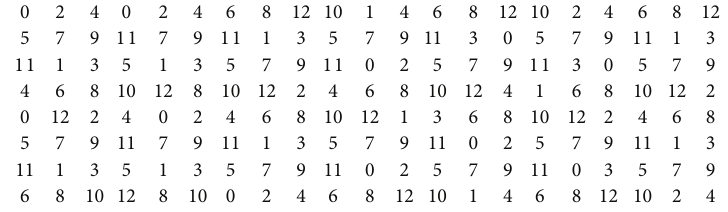
Figure 4: 12 - 𝐿(2, 1) -labeling of 𝐶 8 ⊠ 𝐶 21 .